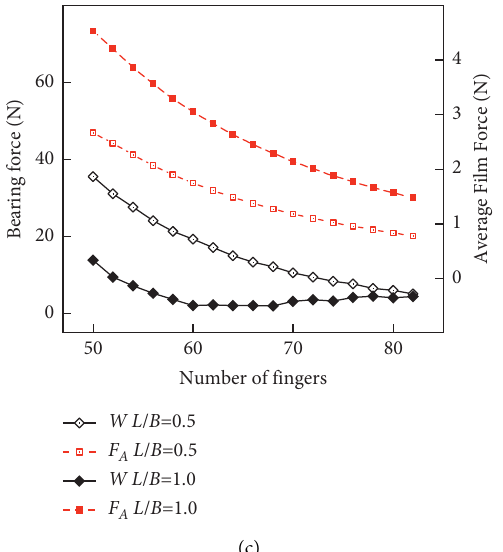
Figure 14: Effects of the number of fingers. (a) Leakages for various numbers of fingers. (b) Friction moment for various numbers of fingers. (c) Bearing force for various numbers of